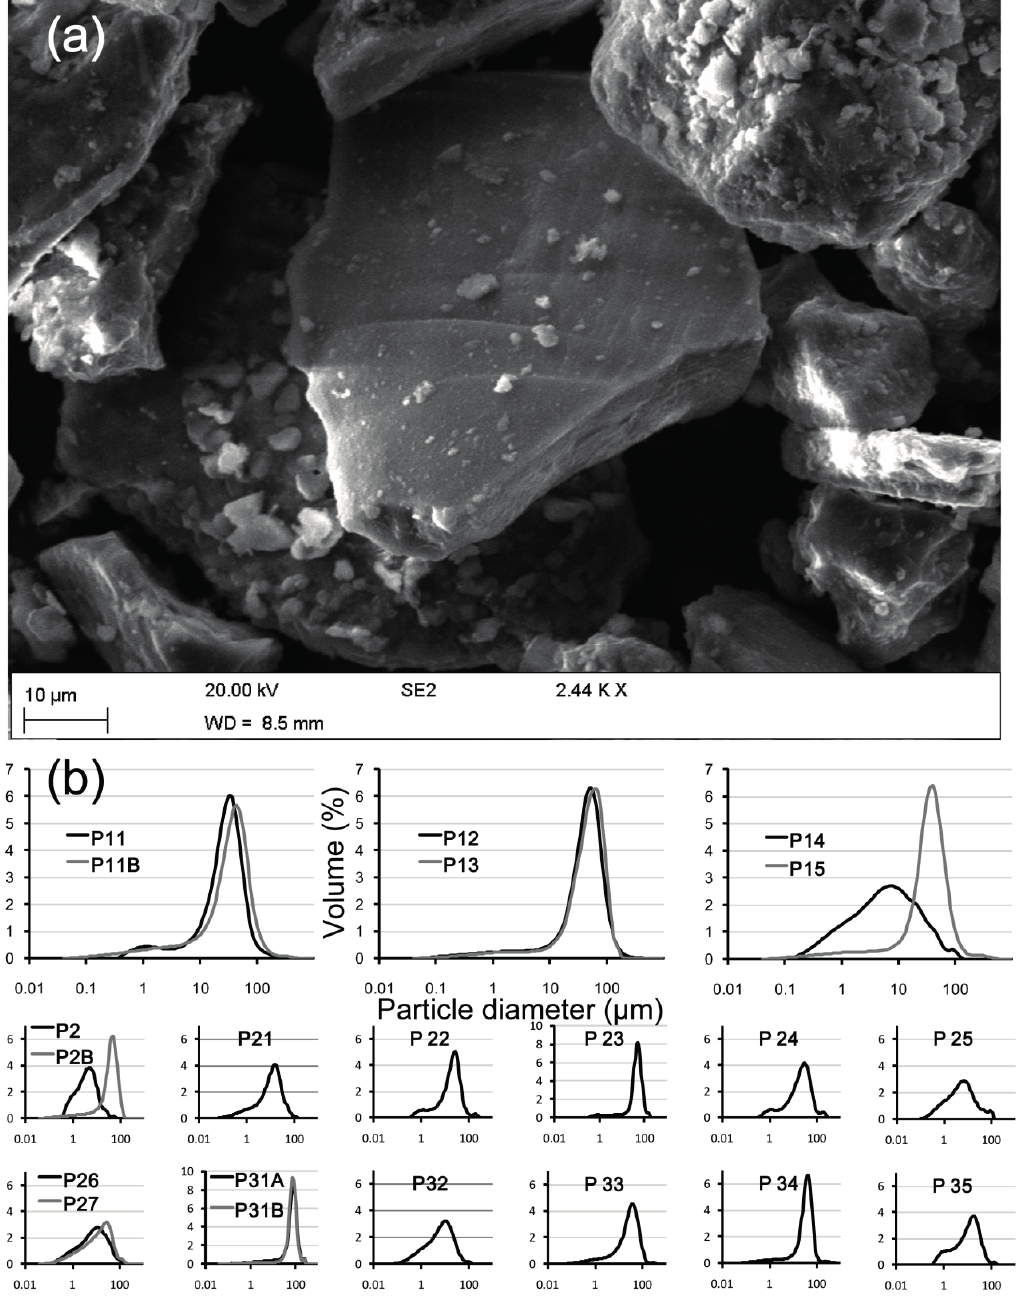
Figure C1. ( a ) SEM image showing a quartz grain in sample P24. This grain exhibits the dominant angular, tabular form of quartz grains from the delta. Some clay particles are seen on the central grain and on the silt-sized particle behind. The growth on the top right particles can be salt crystallisation. ( b ) Differential volume particle size for all samples. Differential volume particle size distribution is the fractional volume of particles of given size, and is equivalent to a distribution by mass if particle density is equal for all sizes